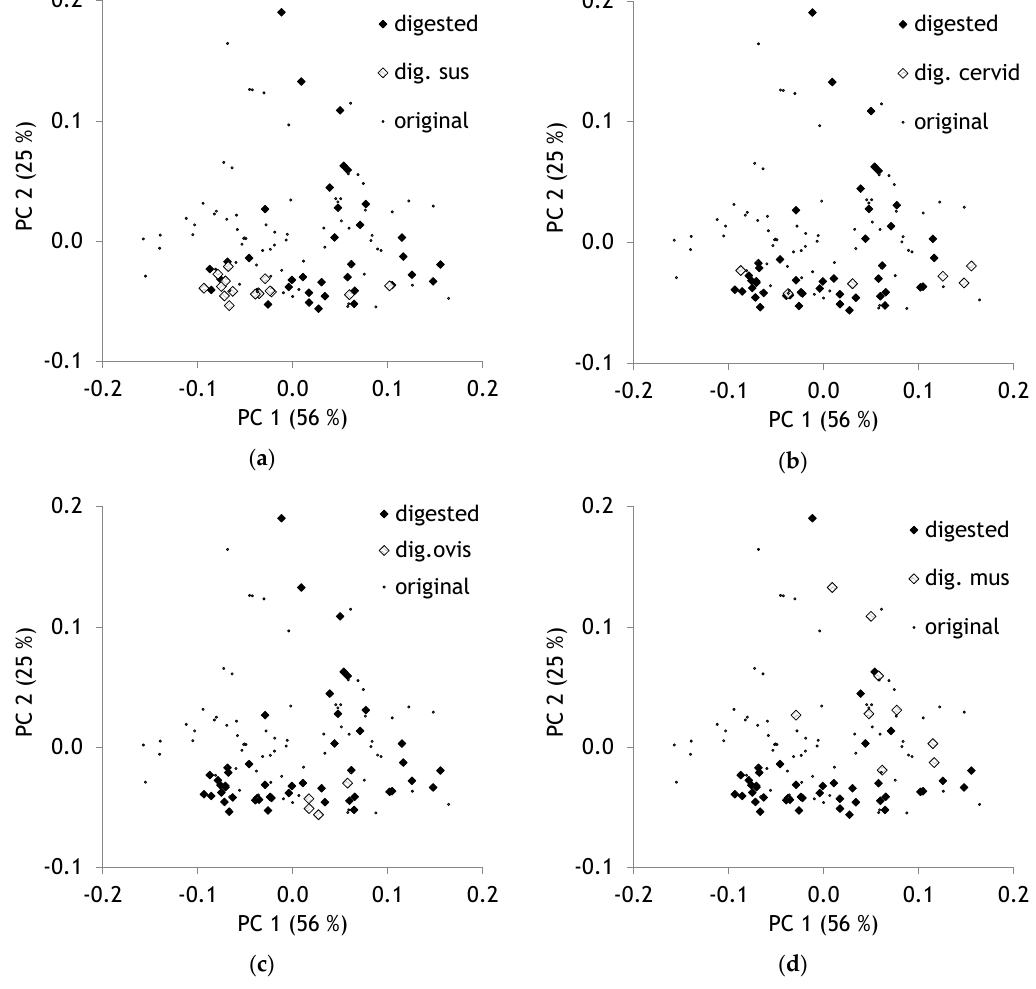
Figure 4. ( a ) Scores plot with highlighted hair samples after passage through the digestive tract of Sus , ( b ) cervids, ( c ) Ovis , ( d )